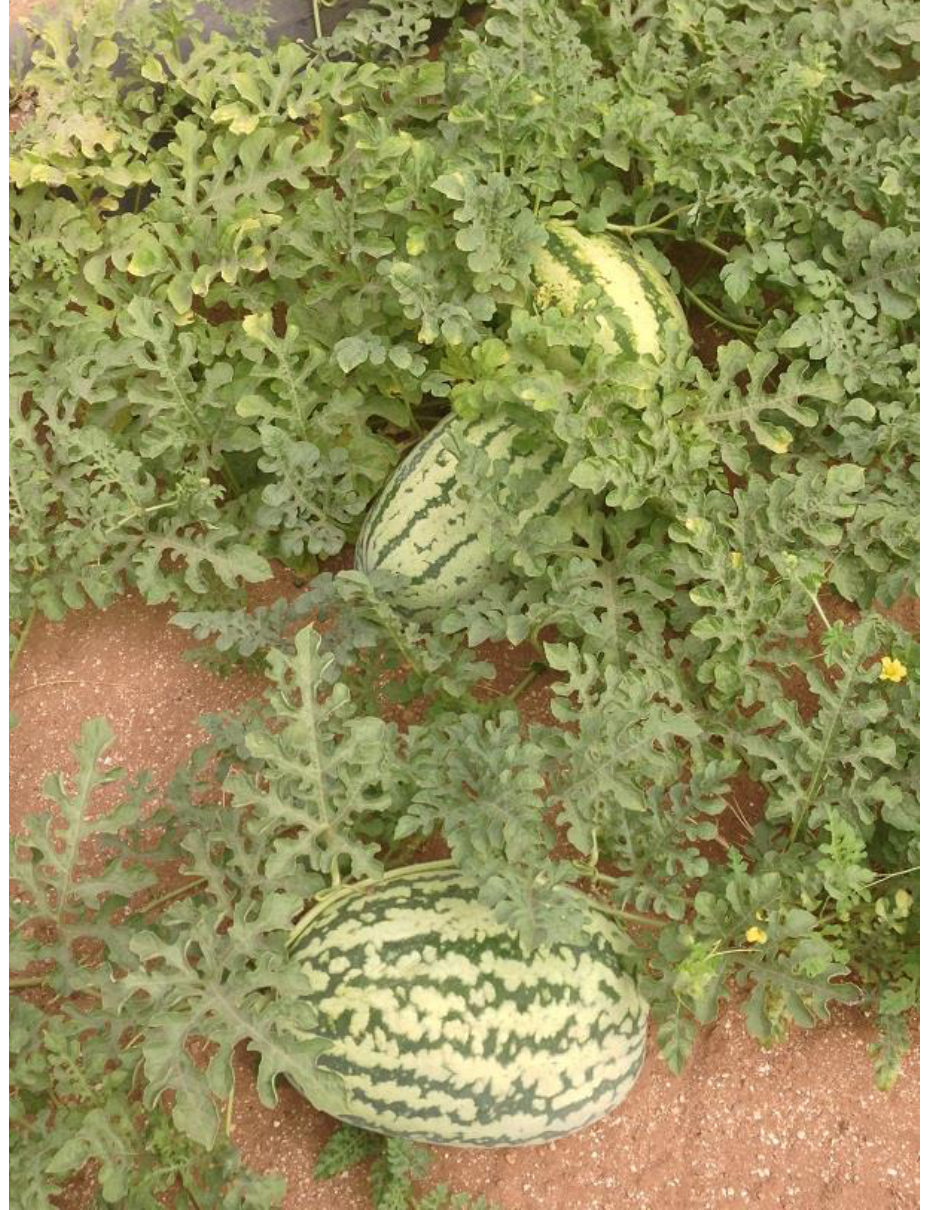
Figure 4. ‘AitOulyad’ watermelon landrace a few weeks prior to the first harvest. Notice the slight diversity in the striping pattern on the